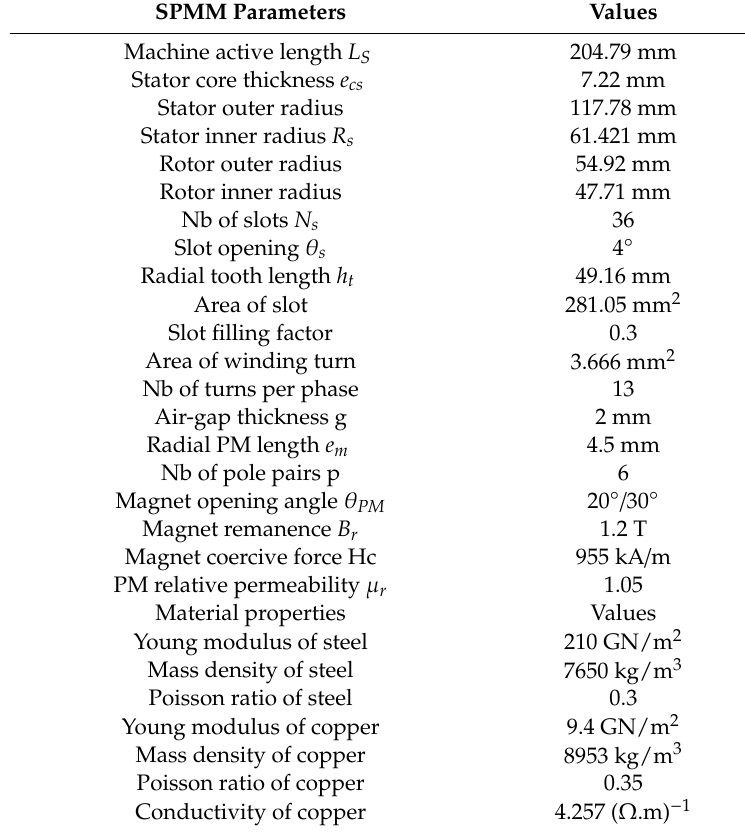
Table 1. Machine’s specifications and